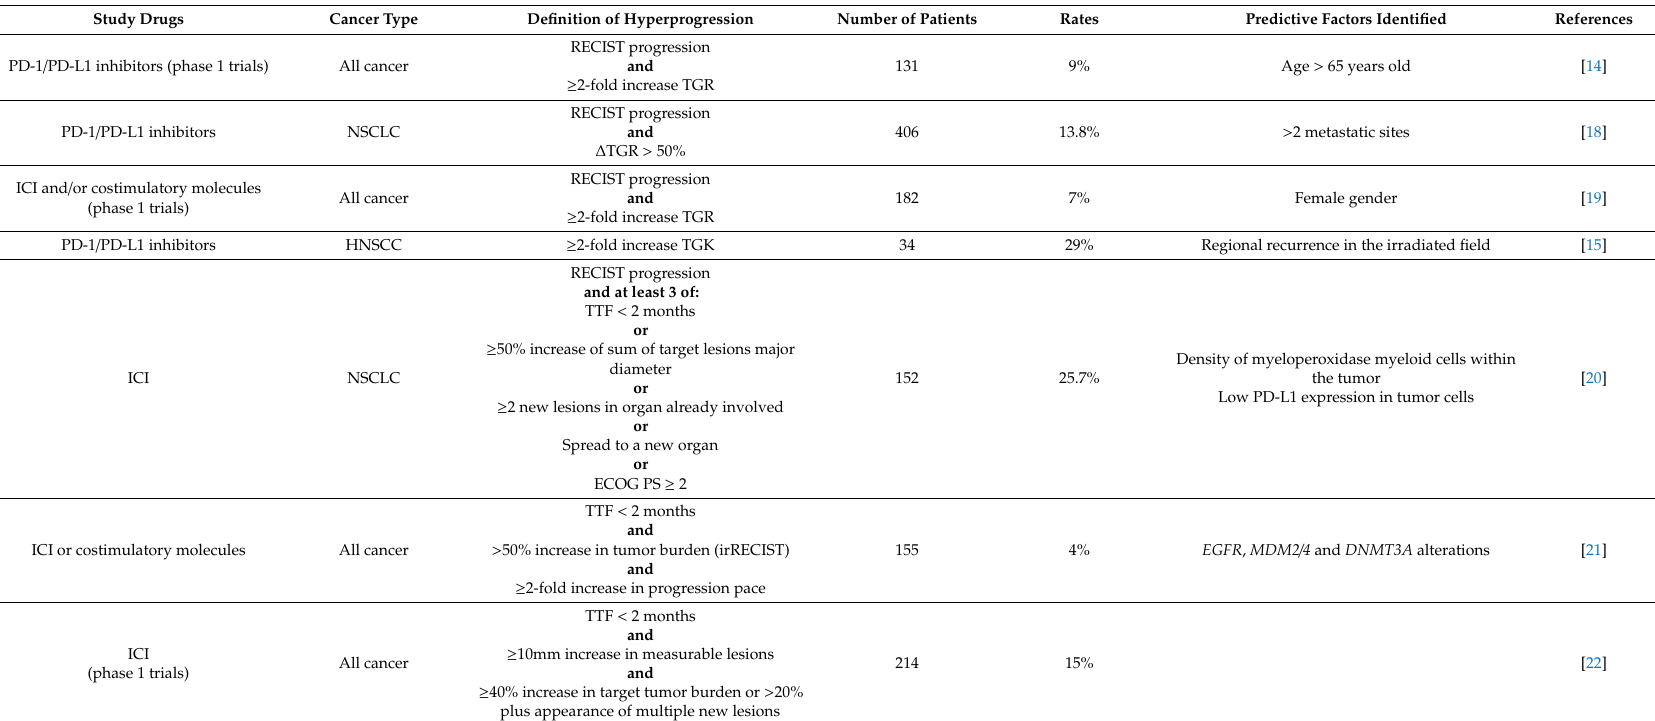
Table 1. Rates of hyperprogression in patients receiving immune checkpoints